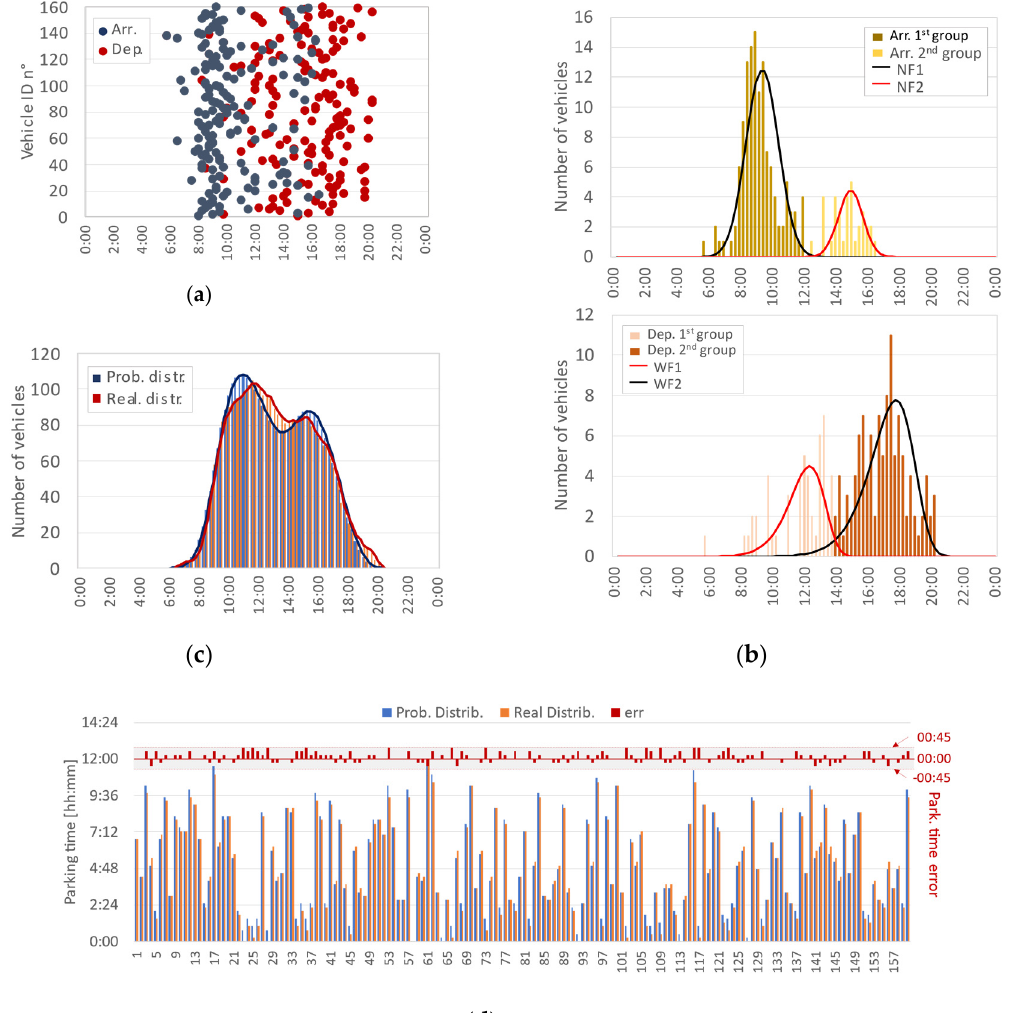
Figure 6. Arrival and departure data referring to a working place parking scenario: ( a ) arrival and departure times for each vehicle; ( b ) top-frame, number of arrivals versus time and its probabilistic function, bottom-frame, the number of departures versus time and its probabilistic function; ( c ) number of total parked vehicles (presences) in each 15 min time intervals. Real data delineate the red plot, and the blue plot is the probabilistic functions; and ( d ) actual and probabilistic data of each vehicle parking time and the resulting error (red data on the top) depicted using the same scale factor. Table 3. Arrivals and departures: data and distribution parameters.